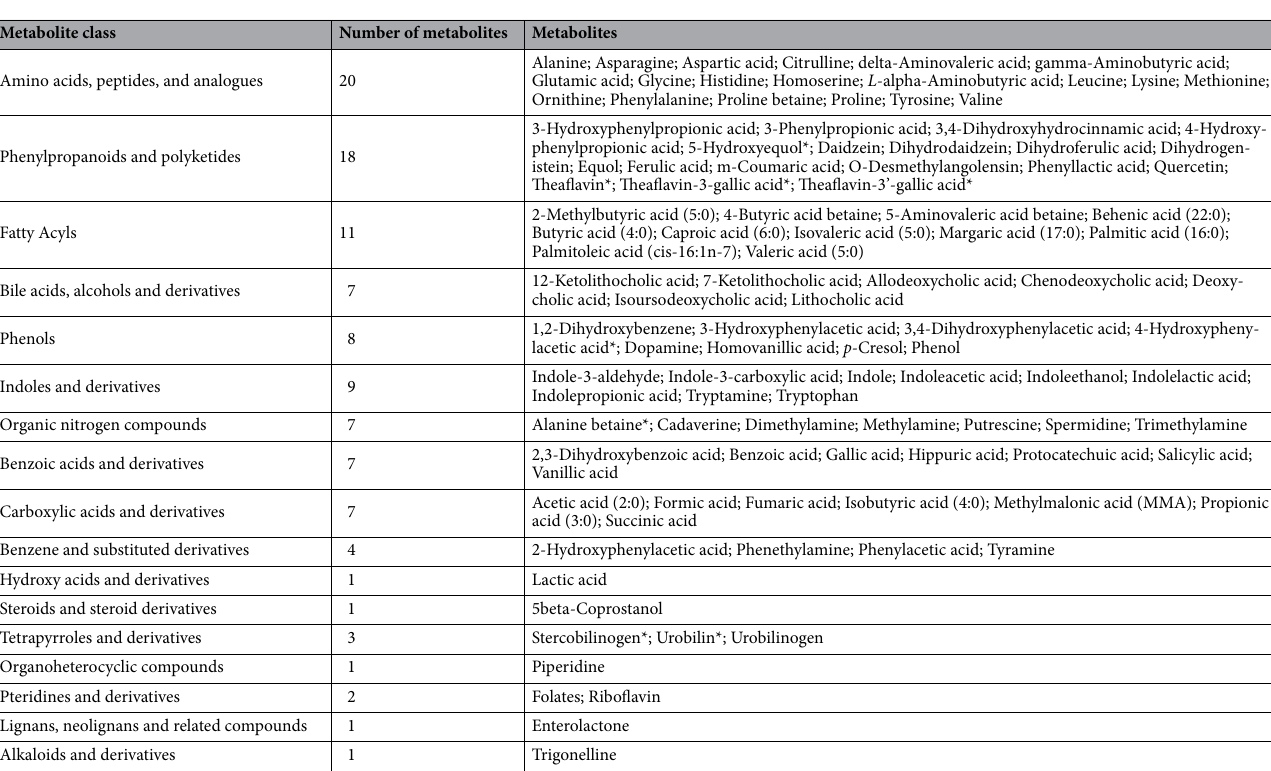
Table 2. Metabolites showing at least two types of evidence supporting their microbial origin [(produced by human faecal bacteria) and (reduced upon either treatment with antibiotics OR reduced in germ- free animals)]. * Concentrations in human biospecimens (blood, urine or faecal samples) are available in Exposome-Explorer for all metabolites except those marked with an